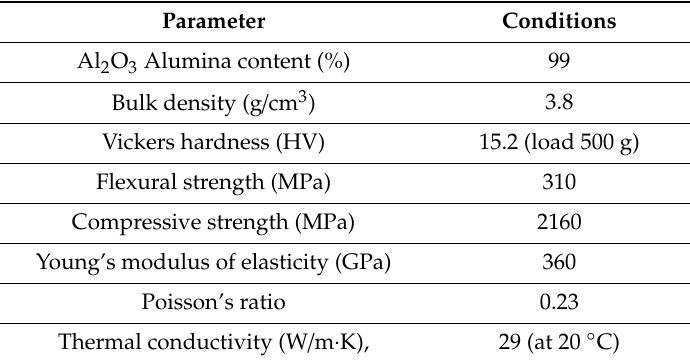
Figure 2. High-speed magnetic abrasive finishing system configuration for micro-machining of fine ceramic bar, A-view: Forward/backward directions of a pole in an attempt for the processing. Table 1. Material Characteristics of Al 2 O 3 fine ceramics.